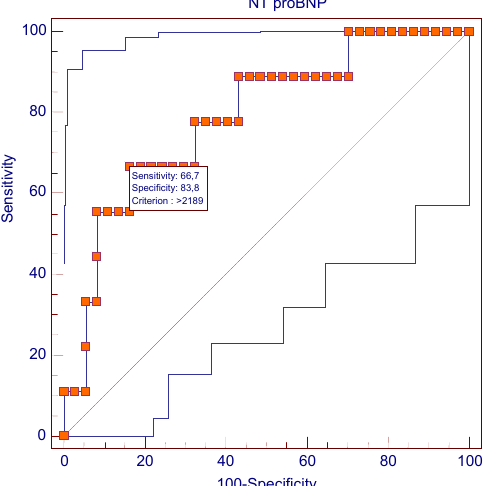
Fig. 2. ROC-curve for prediction of MACEs in STEMI patients using NT proBNP